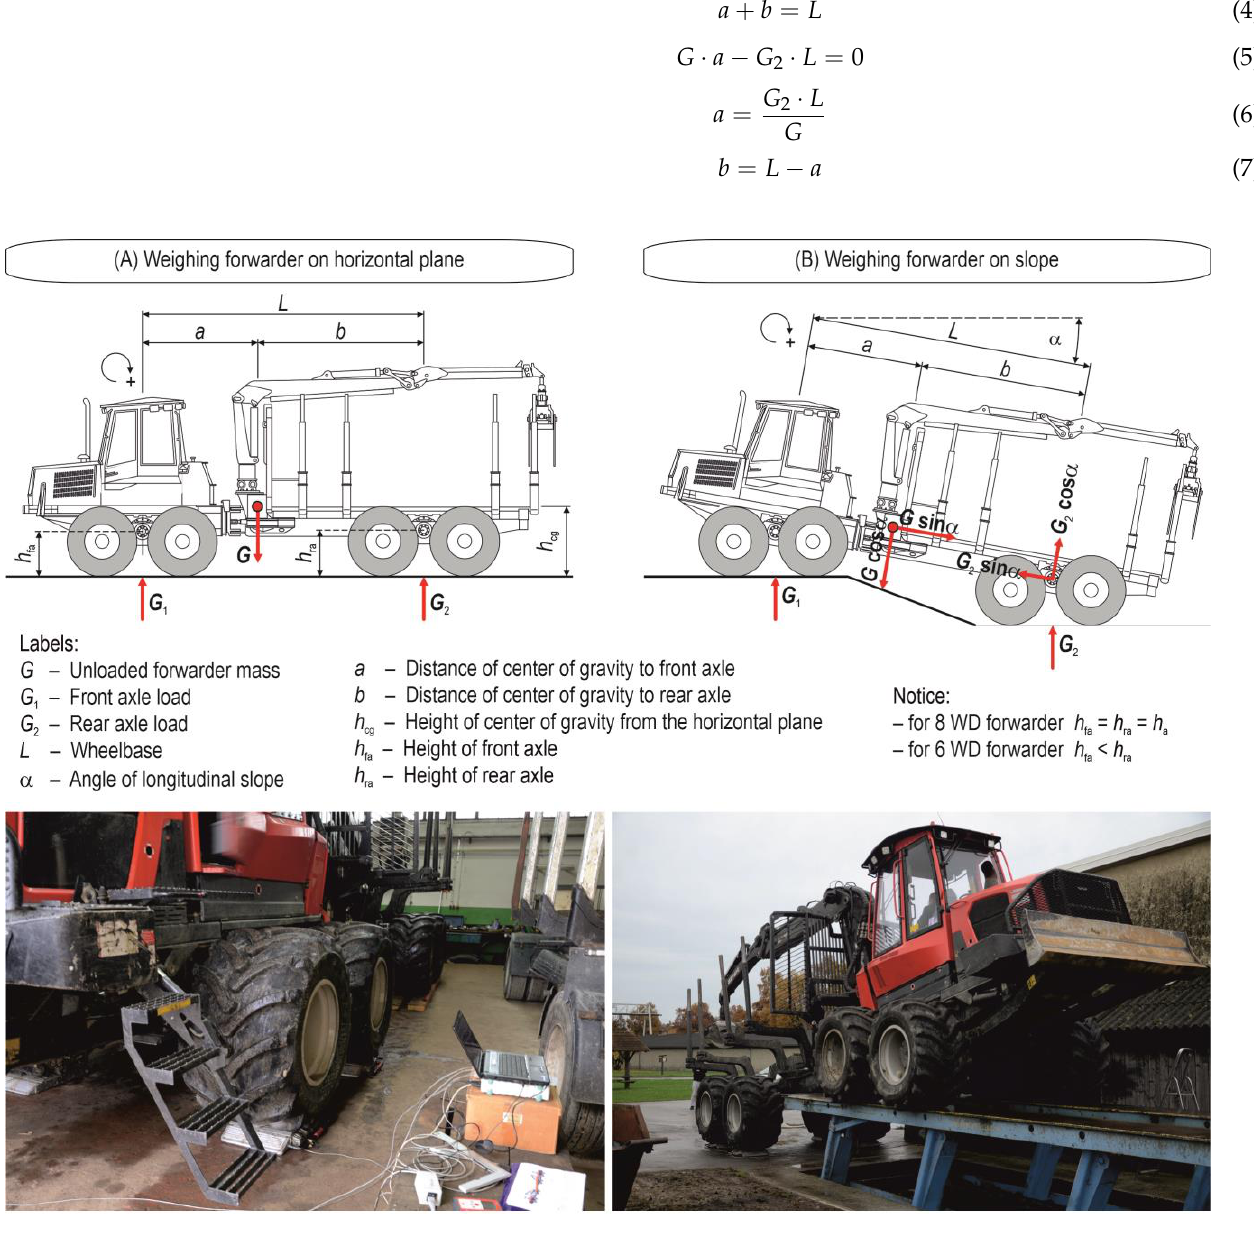
Figure 3. Determining the centre of gravity of the forwarder in ( A ) horizontal plane and ( B ) on slope.